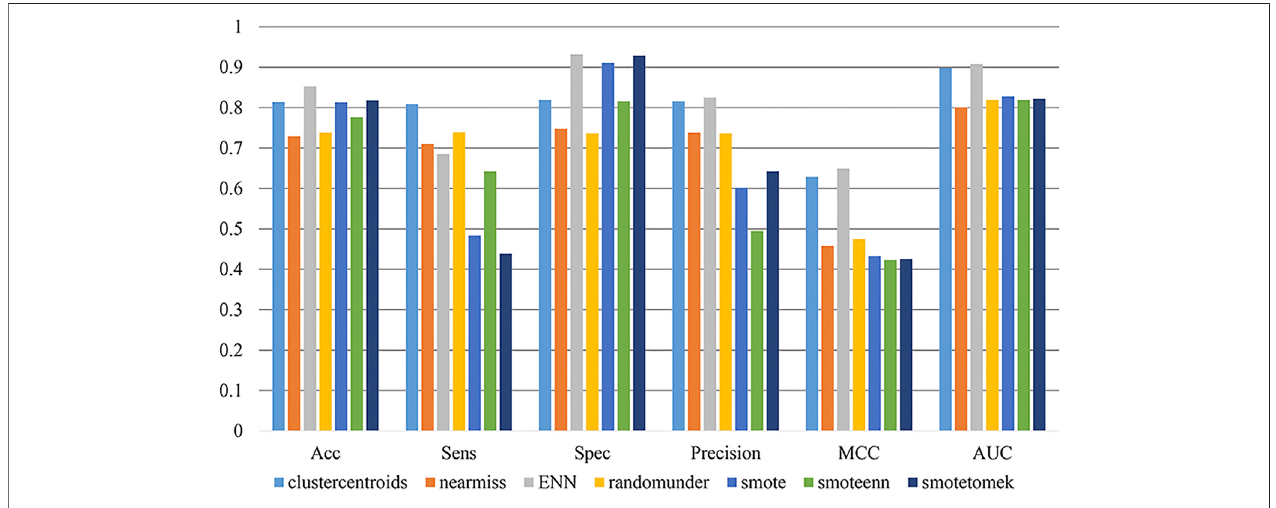
FIGURE 2 | The values of the different unbalanced data processing methods on the training set.